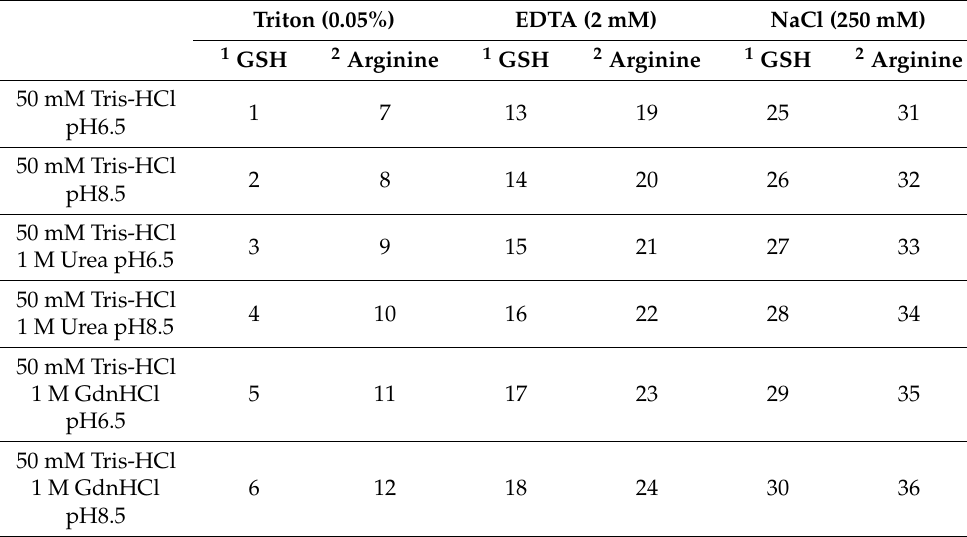
Table 1. Combinations of buffer used for protein